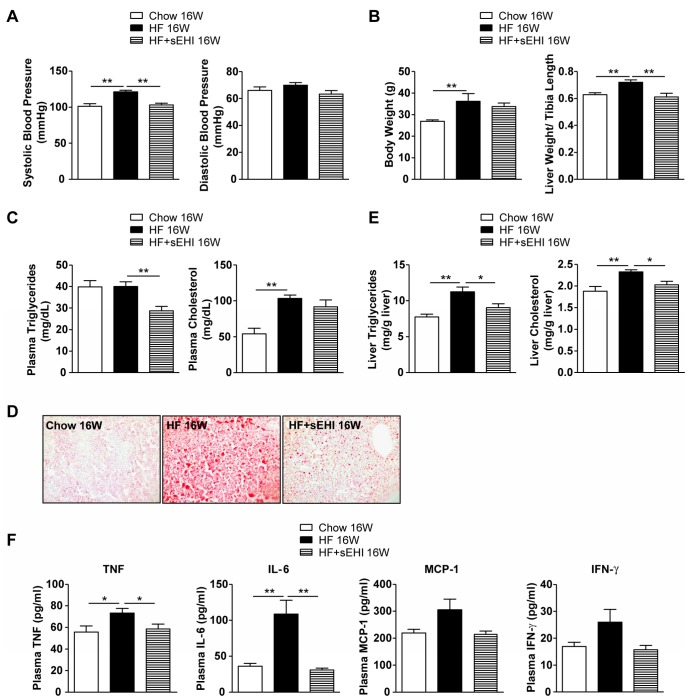
Full-term sEH inhibitor administration attenuated 16-week HF-diet–induced hepatic steatosis.Male C57BL/6 mice were fed a regular chow or HF diet for 16 weeks with or without sEHI t-AUCB in drinking water starting from 3 days before diet (Chow 16W: n=10, HF 16W: n=15, HF 16W+sEHI 16W: n=11). (A) Systolic and diastolic blood pressure. (B) Body weight and ratio of liver weight compared to tibia length. (C) Plasma levels of triglycerides and cholesterol. (D) Oil-red O staining in liver sections. (E) Levels of triglycerides and cholesterol in liver. (F) Proinflammatory cytokine levels in plasma. Data are mean ± SEM. (* P<0.05, ** P<0.01).